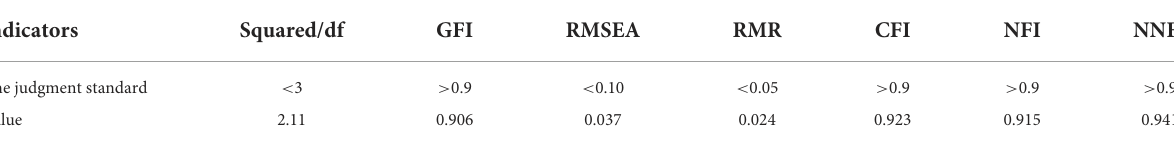
TABLE 9 Modified model variable fitting